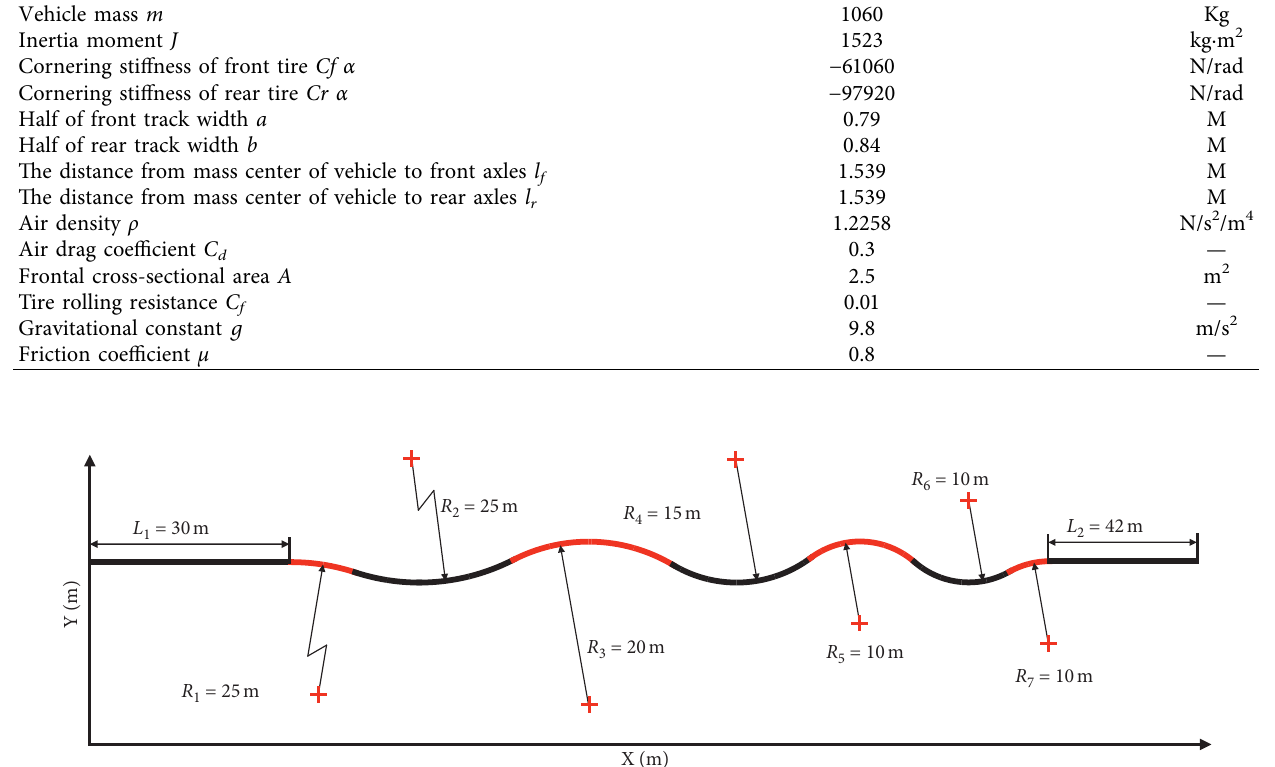
Figure 3: Schematic of the planned path.